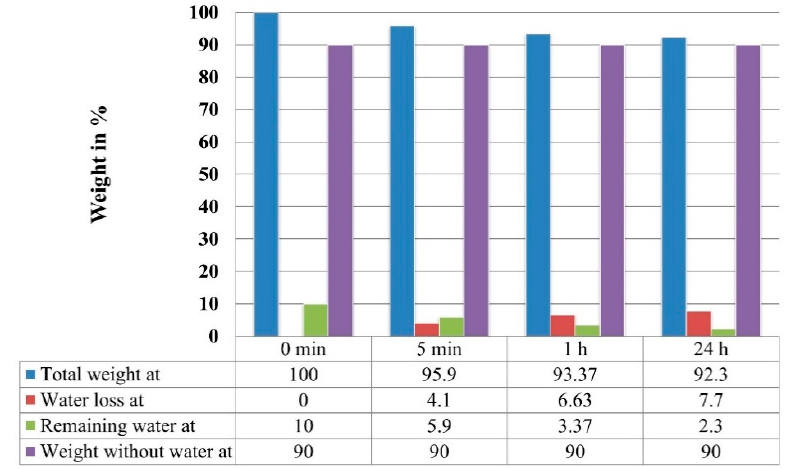
Figure 3. Water-loss percentage (%) of dentin beams calculated assuming that human dentin’s water content is about 10% by weight [17].